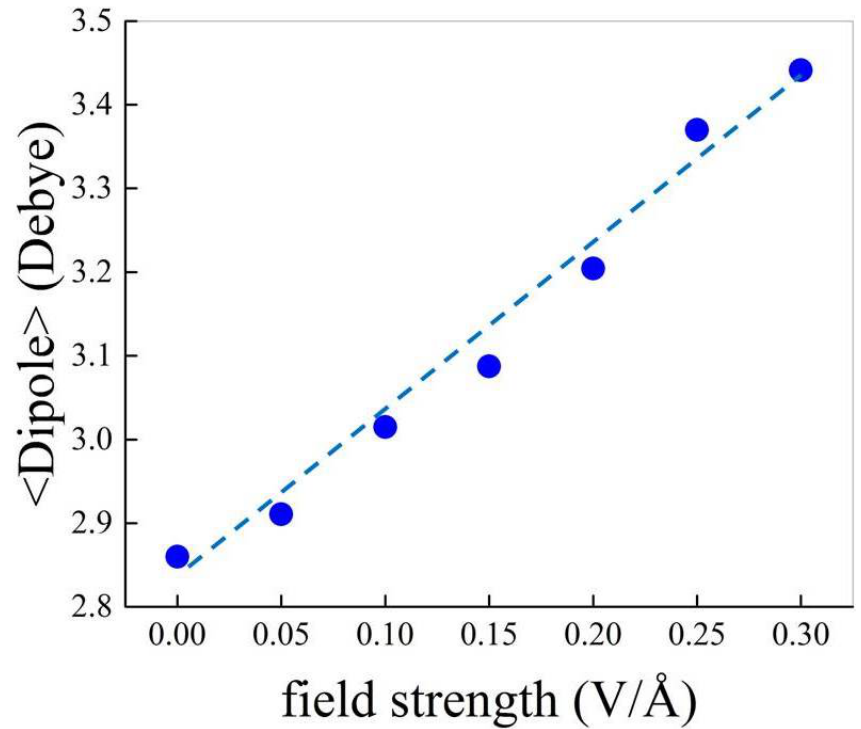
Figure 4. Average molecular dipole moment magnitude as a function of the field strength. Calculated points are plotted as full blue circles whereas the linear fit is presented as dashed blue